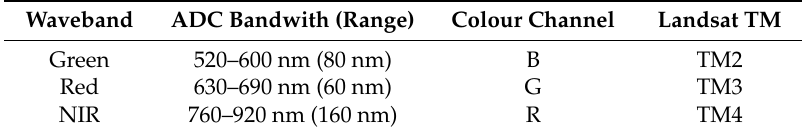
Table 2. Tetracam ADC camera waveband, bandwidth and colour channel specifications 1 .